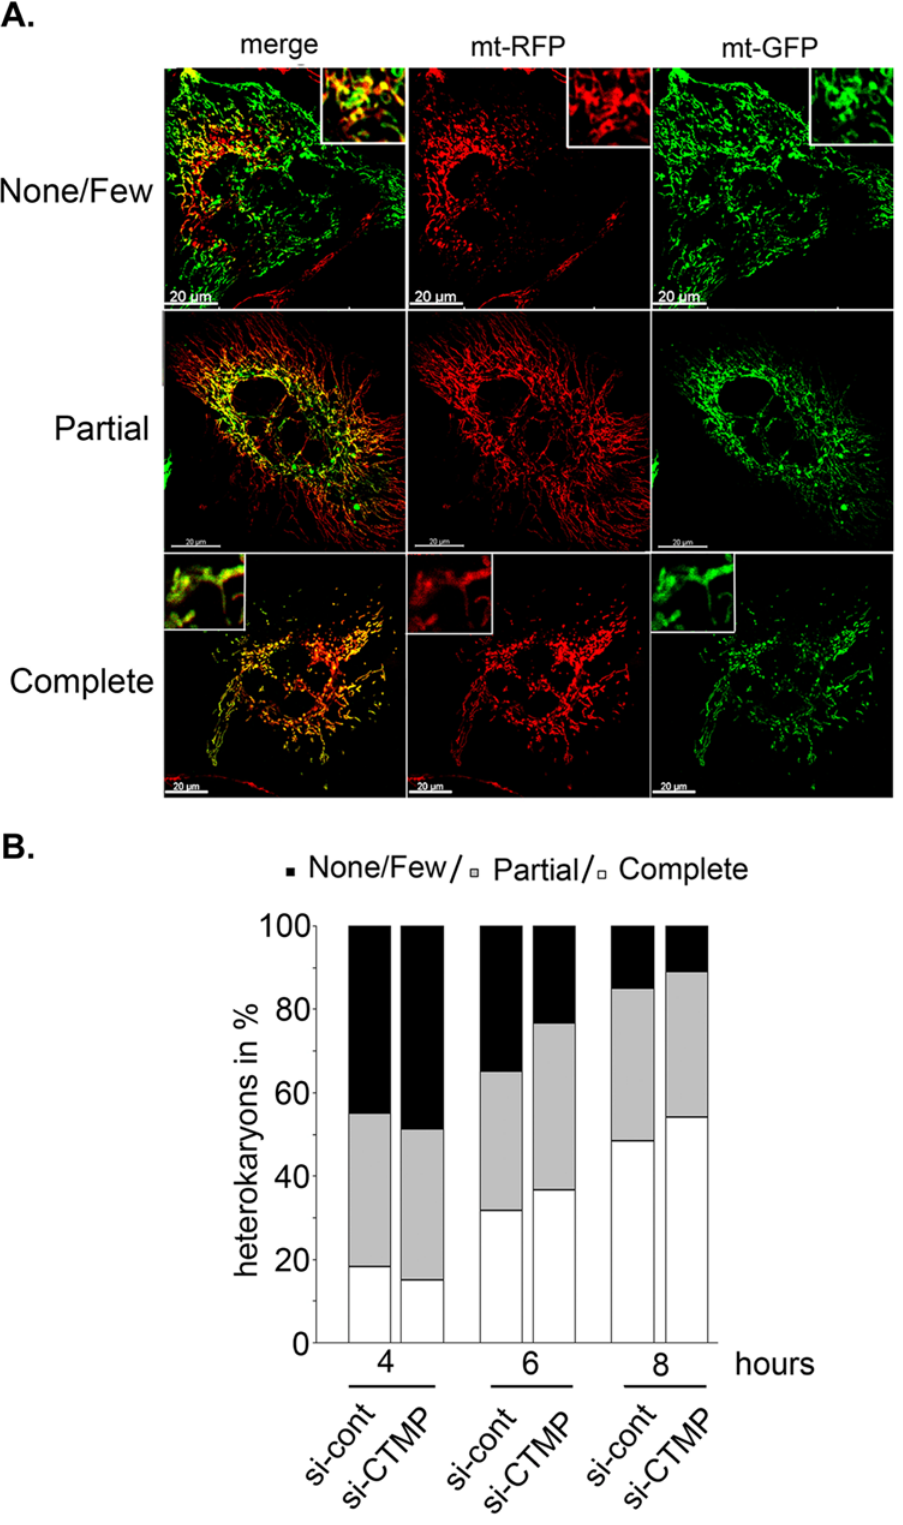
Figure 4. CTMP is not required for mitochondrial fusion. (A) Hela cells expressing mt-RFP and mt-GFP transfected with either siRNA # 1 and # 2 against CTMP or the siRNA control were fused in 50% PEG1500 for 60 s, washed and fixed at different times (4, 6 and 8 h). (B) Time-course of mitochondrial fusion in HeLa cells treated as in (A). Mitochondrial fusion was measured from 30 randomly selected polykaryons and classified as described in (A), n =2.